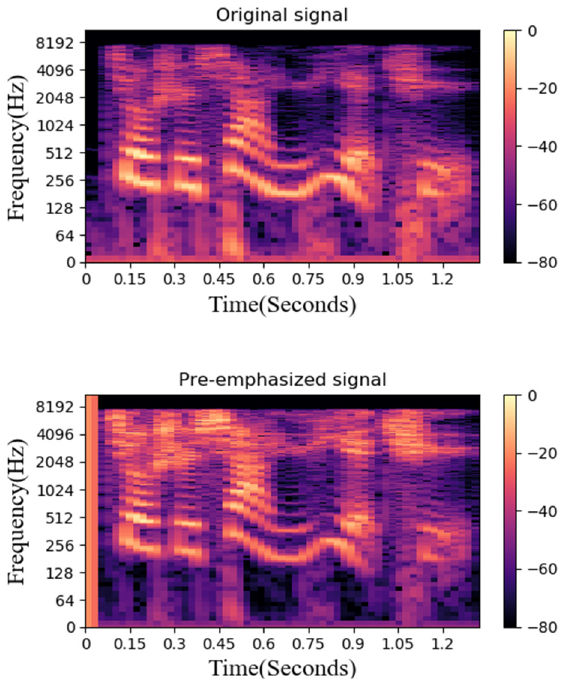
Figure 8. Original data and spectrogram after pre-emphasize.